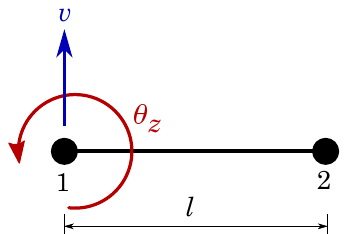
Figure A1. Beam element of length l with two nodes and 2 DOF in each end, the transverse displacement v and the rotation θ z